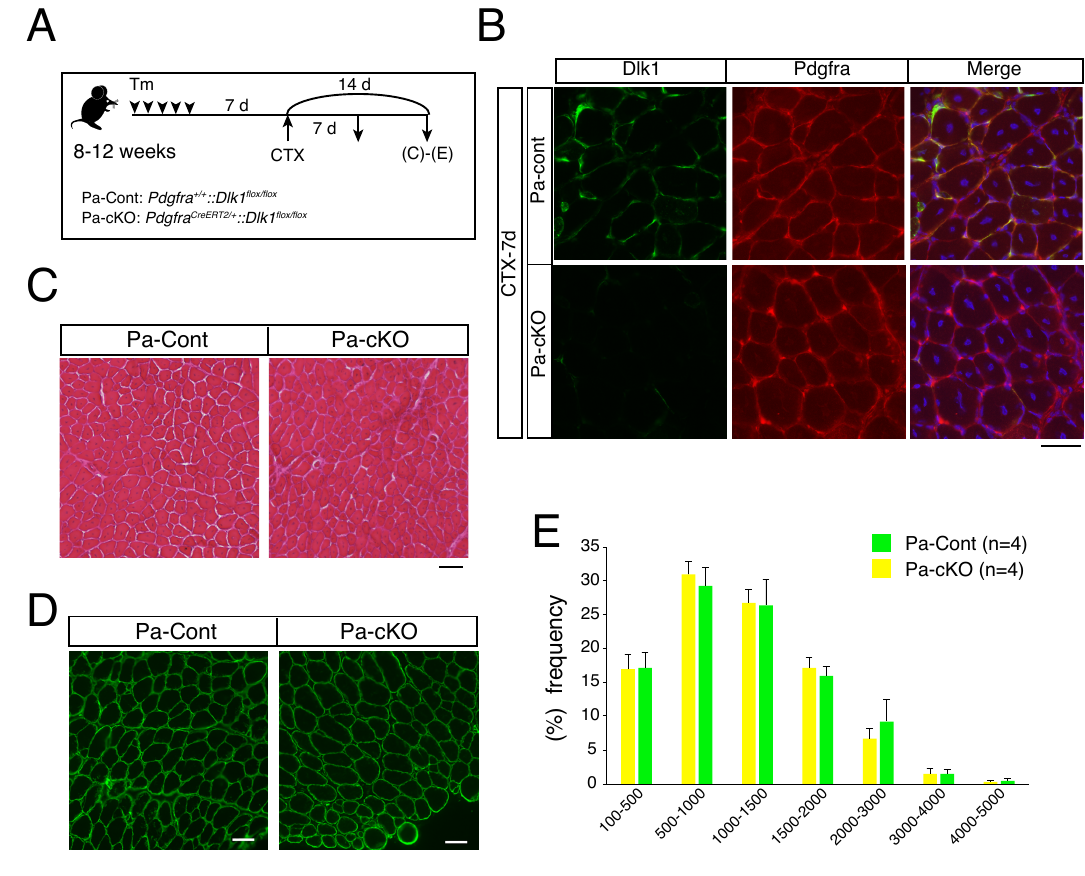
Figure 4. Depletion of Dlk1 in mesenchymal progenitors. ( A ) Cardiotoxin (CTX) and tamoxifen (Tm) time scheme for analysis of the regenerative potential in Pa-control and Pa-cKO mice. ( B ) Immunostaining of Dlk1 (green), Pdgfr α (red), and DAPI (blue) in the regenerating TA muscle of Pa-control and Pa-cKO seven days after CTX injection. Scale bar: 50 µ m. ( C ) TA muscle sections of Pa-control and Pa-cKO mice were examined by H&E staining two weeks after CTX injection. Scale bar: 50 µ m. ( D ) Immunostaining of laminin α 2 (green) in Pa-control and Pa-cKO regenerated TA muscle 14 days after CTX injection. Scale bar: 50 µ m. ( E ) Graphs indicate the quantitative analyses of the myofiber areas in Pa-control (green bar) and Pa-cKO (yellow bar) mice. The y-axis shows the percentage of each size of myofibers. The x-axis shows the size of myofibers. Data show the average of four mice per group from two independent experiments with